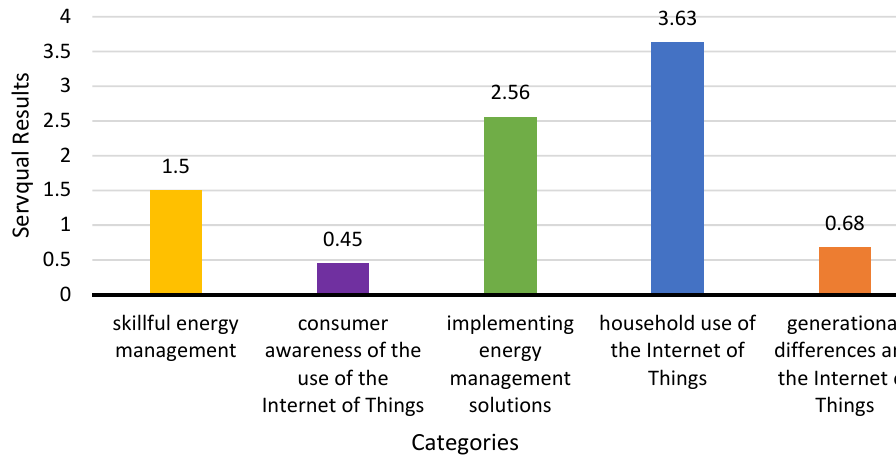
Figure 4. The arithmetic scores for the Servqual analysis. Table 4. Validation assessment of five dimensions for the Servqual